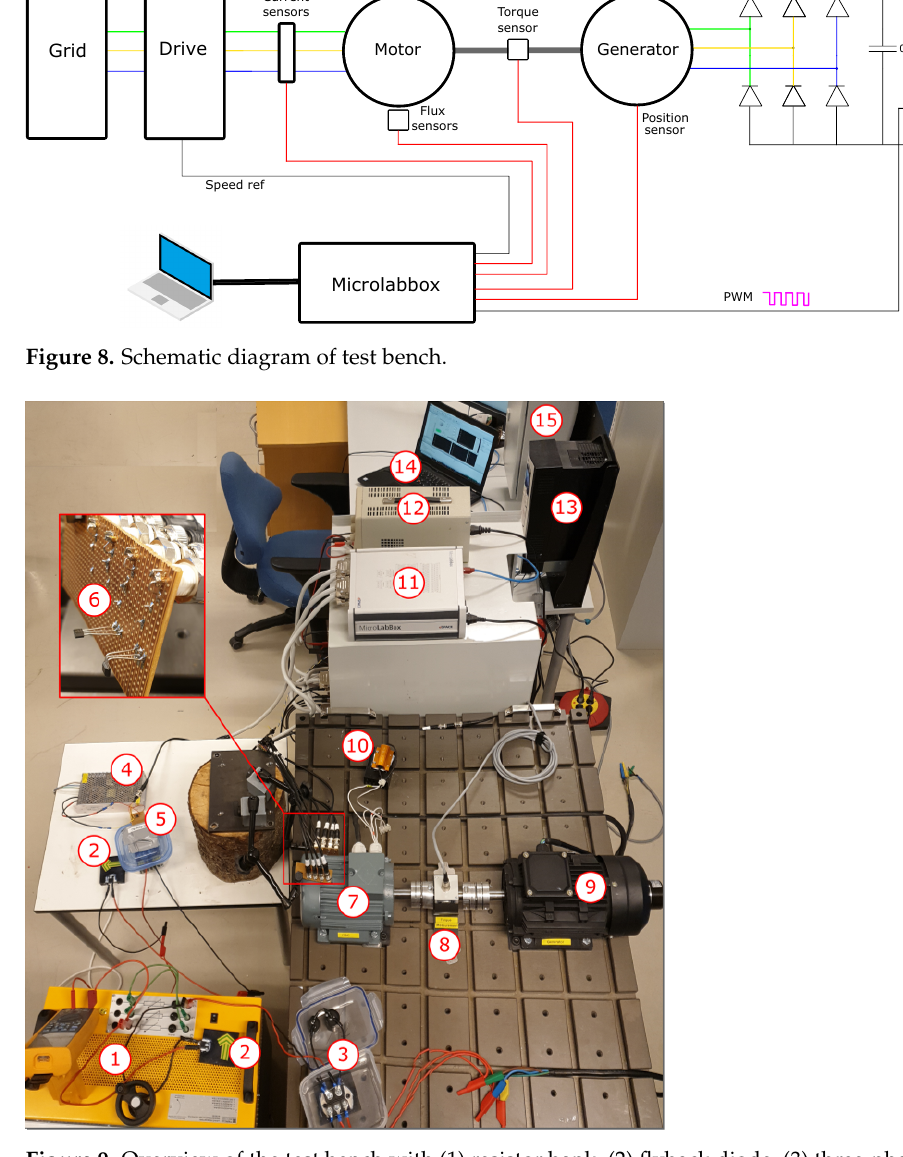
Figure 9. Overview of the test bench with (1) resistor bank, (2) flyback diode, (3) three-phase rectifier with capacitor bank, (4) 12 V DC supply, (5) IGBT brake chopper with op amp, (6) hall sensors, (7) PMSM, (8) torque sensor, (9) generator, (10) fault resistor, (11) Microlabbox, (12) 24 V DC-supply, (13) ABB drive, (14) office laptop, and (15) cabinet containing the current sensors. Table 1. Nameplate parameters for IE5-PS2R 90